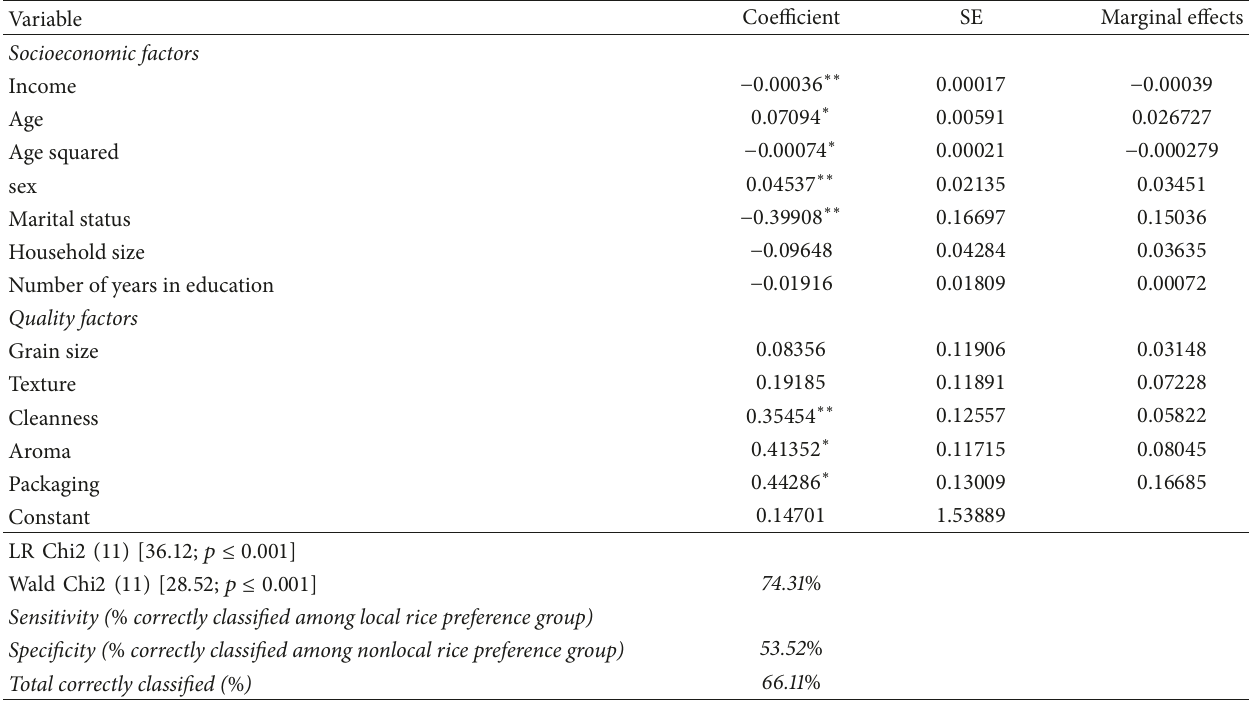
Table 4: Factors influencing preference for local